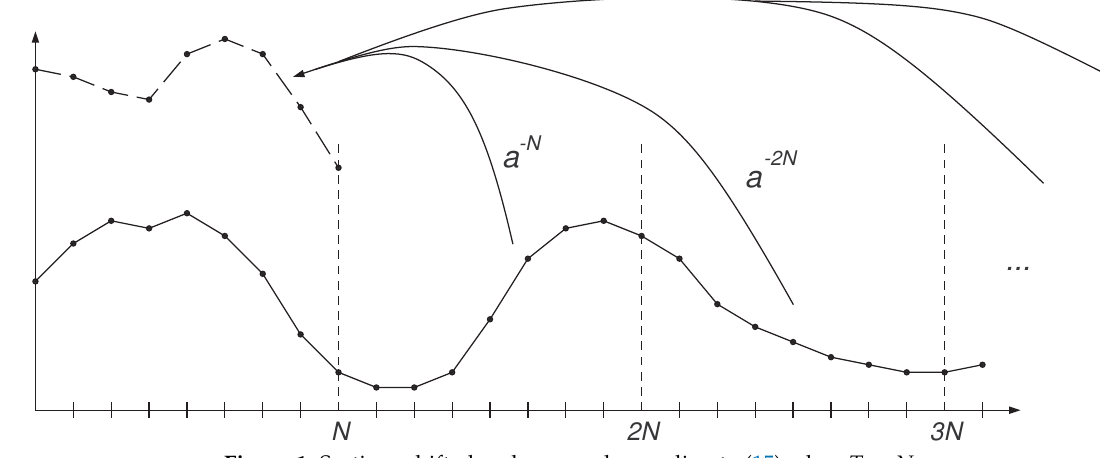
Figure 1. Sections shifted and summed according to (15) when T < N